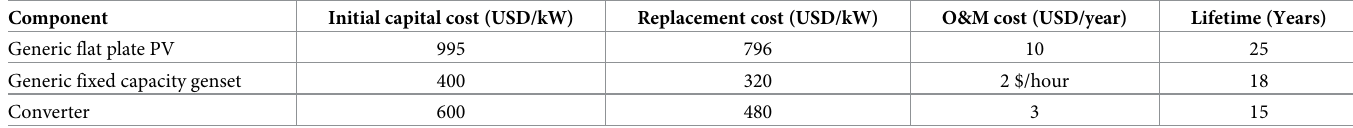
Table 5. Major system